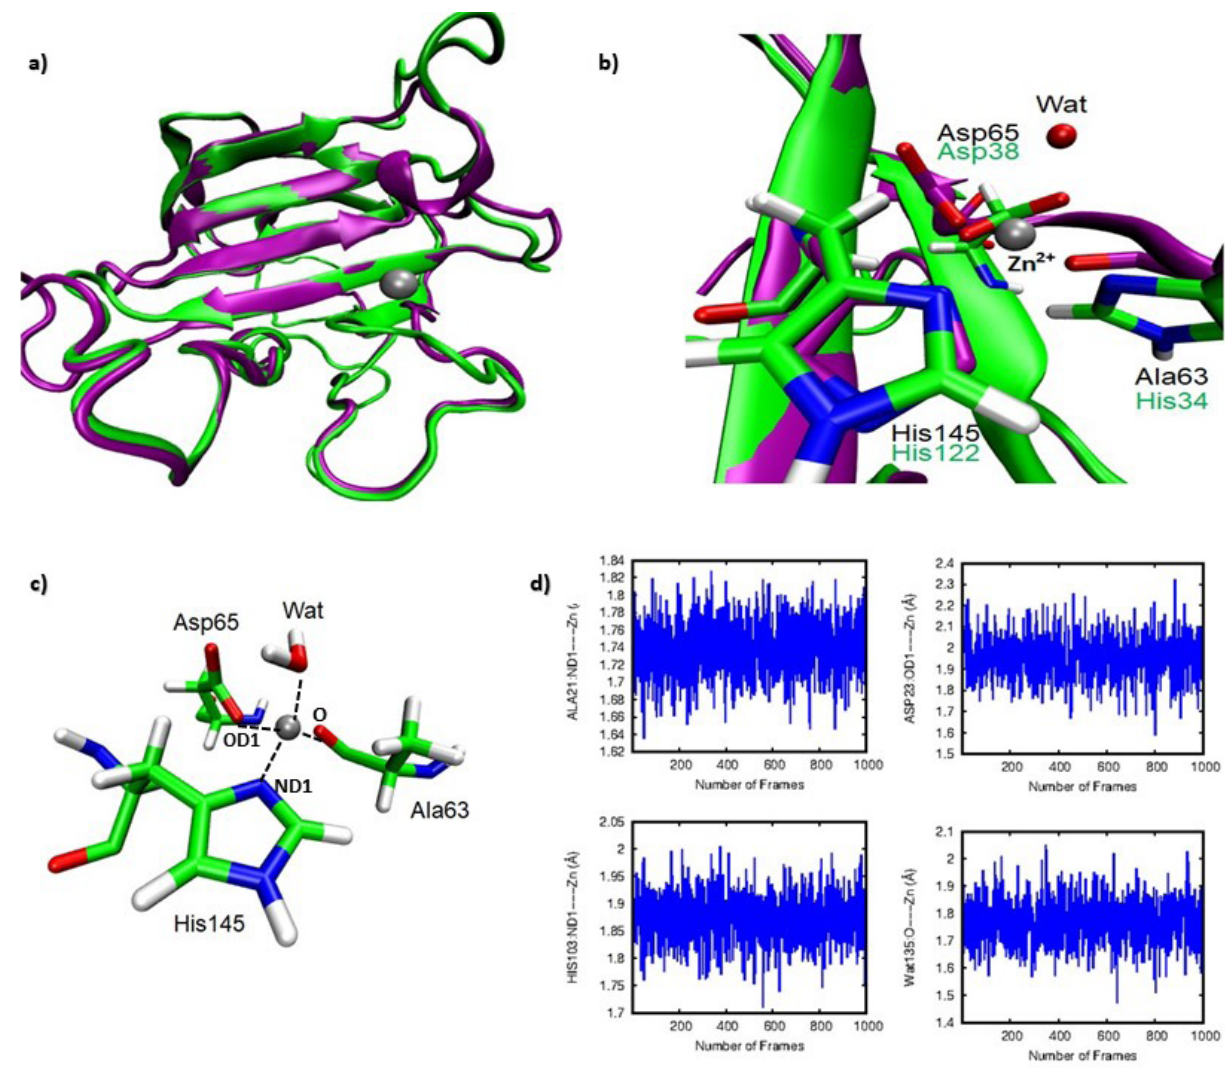
Figure 4 – Molecular Dynamics results for Zoocin A. (a) Superposition of the zoocin model (purple) and zoocin A from Streptococcus equi subspecies zooepidemicus strain 4881 (green). (b) Position of residues His145, Asp65, Ala63 and a water molecule forming a tetrahedral coordination with Zn 2+ in the active site. (c) Key distances for Zn 2+ center computed during simulation. (d) Root-mean-square deviation (RMSD) plot computed during 10 ns of MD simulations shows a good stability for the Zoocin A